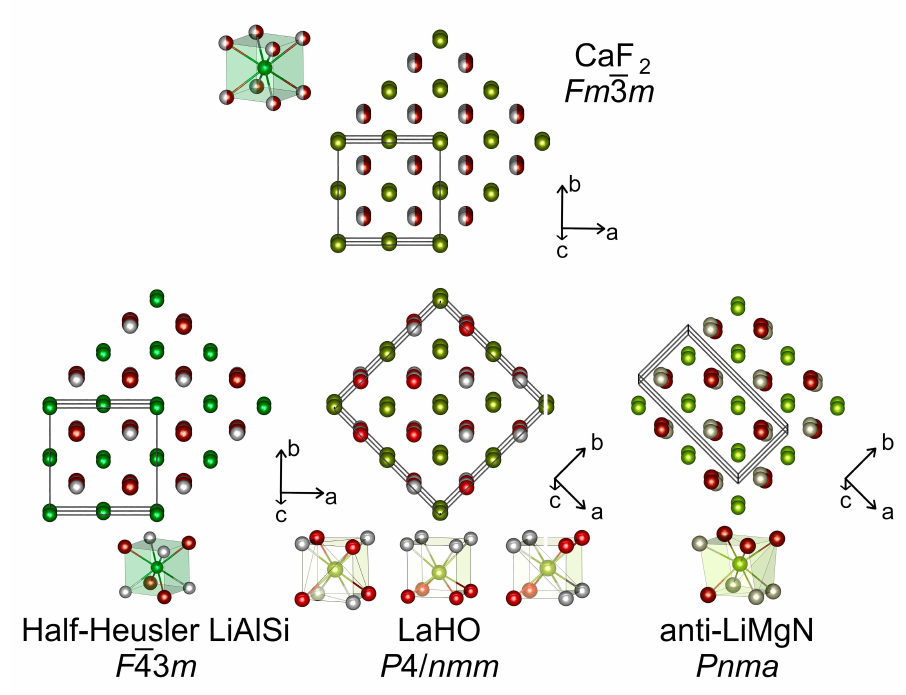
Figure 1. The crystal structures of RE HO modifications with metal coordination polyhedra, structure types and space group types. The monoclinic LaHO modification with space group P 12 1 / m 1 is a slightly distorted variety of the presented anti-LiMgN structure type ( translationengleiche transition of index 2) [34]. All structure types are crystallographically related [42]. Color code: RE , green; H, white; O, red. Reprinted with permission from Inorg. Chem . 2021, 60, 6, 3972–3979. Copyright (2021) American Chemical